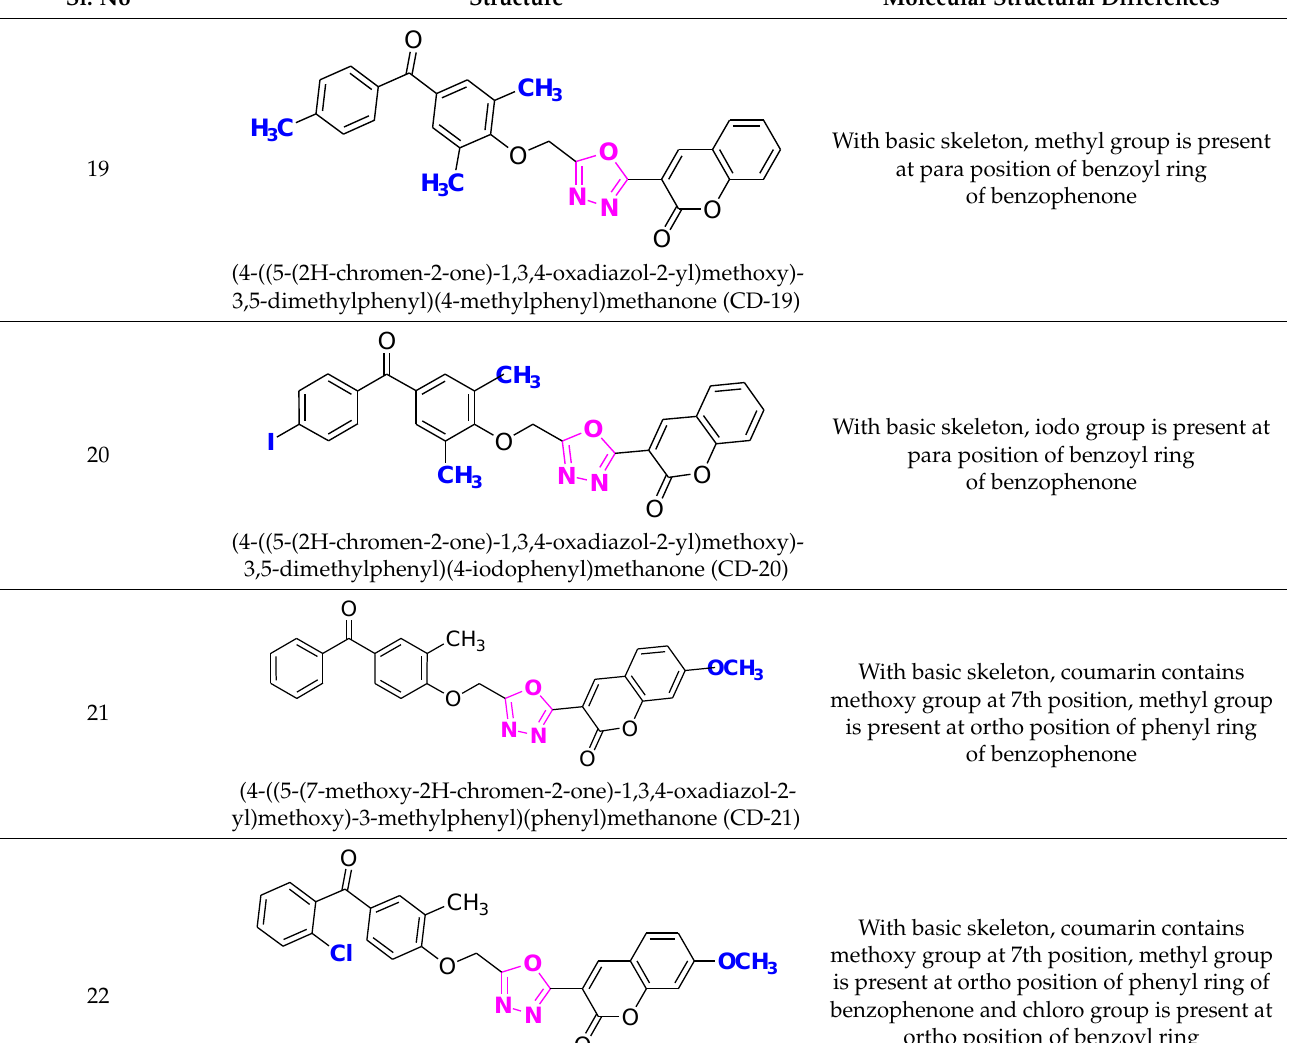
Table 1. Cont. Sl. No Structure Molecular Structural Differences